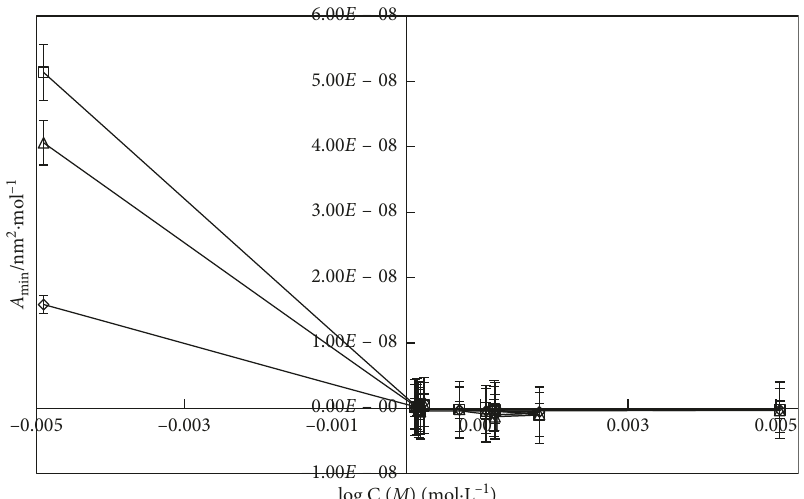
Figure 8: The A value of the SDS-rich surfactant at the three different temperatures T � 293.15 ( ◊ ), 298.15 ( □ ), and 303.15K ( △ ), min respectively.